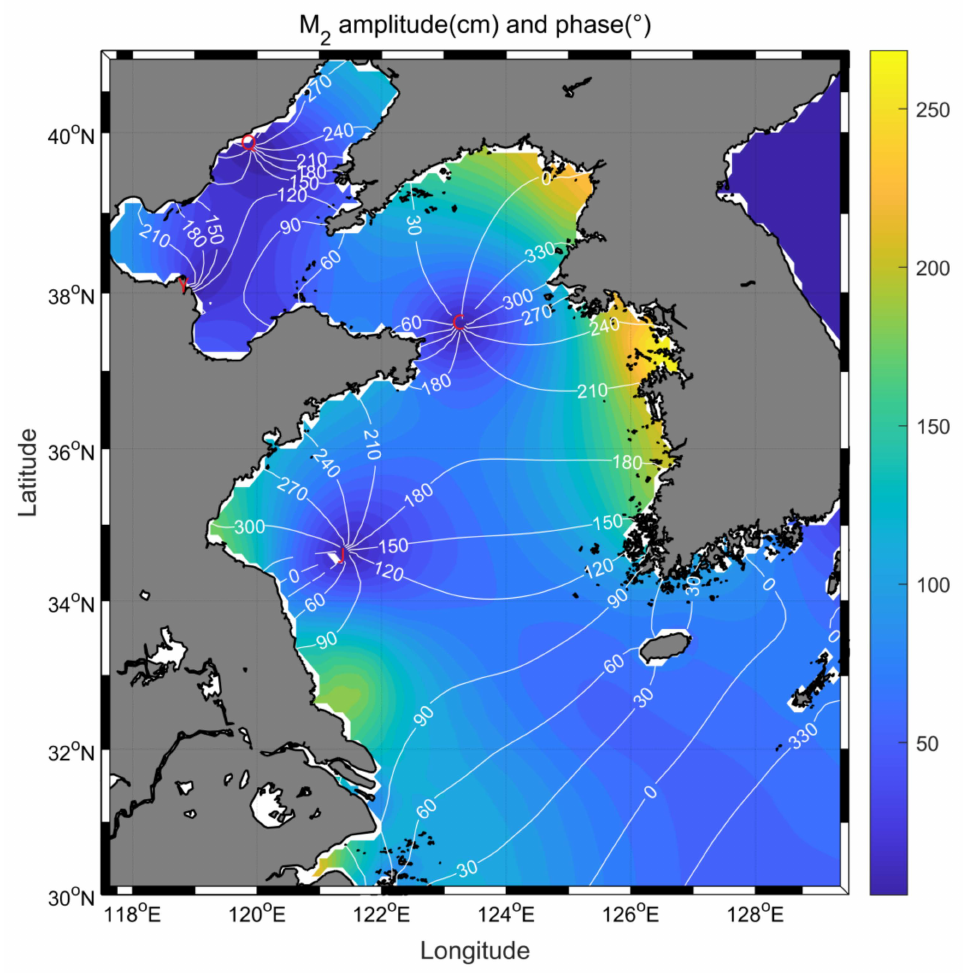
Figure 1. Cotidal chart for M 2 in the BYS based on the EOT20 model [32], in which the color and white lines represent the amplitude and phase lag,